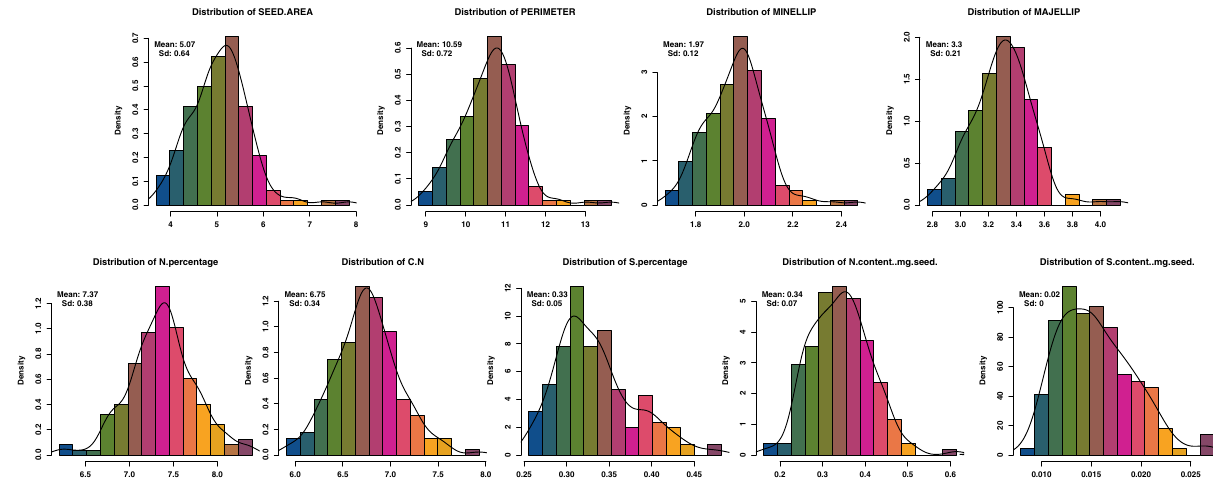
Figure 2. Distribution histograms of seed size and composition phenotypes in different Medicago accessions. Corresponding distribution curves are indicated on histograms. Different x-axes represent the corresponding values of the